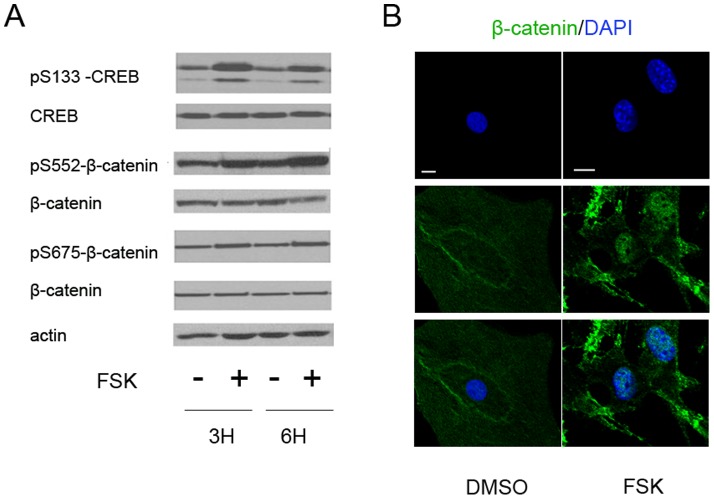
Stimulation of PKA by FSK increases β-catenin phosphorylation and nuclear relocalization in MC3T3-E1 cells.A. Protein lysates were prepared from MC3T3-E1 cells treated with vehicle for Forskolin (FSK) for the times indicated and blotted with the antibodies shown. Note the increases in pS133-CREB, pS552- and pS675- β-catenin at both timepoints without changes in total protein levels. Actin is shown as a loading control. 20 µg of protein were loaded per lane. B. Immunofluorescence tracking of β-catenin after vehicle (DMSO) or FSK treatment in MC3T3-E1 cells. The bottom row shows a merged images from the panels above. Scale bar: 10 µm.